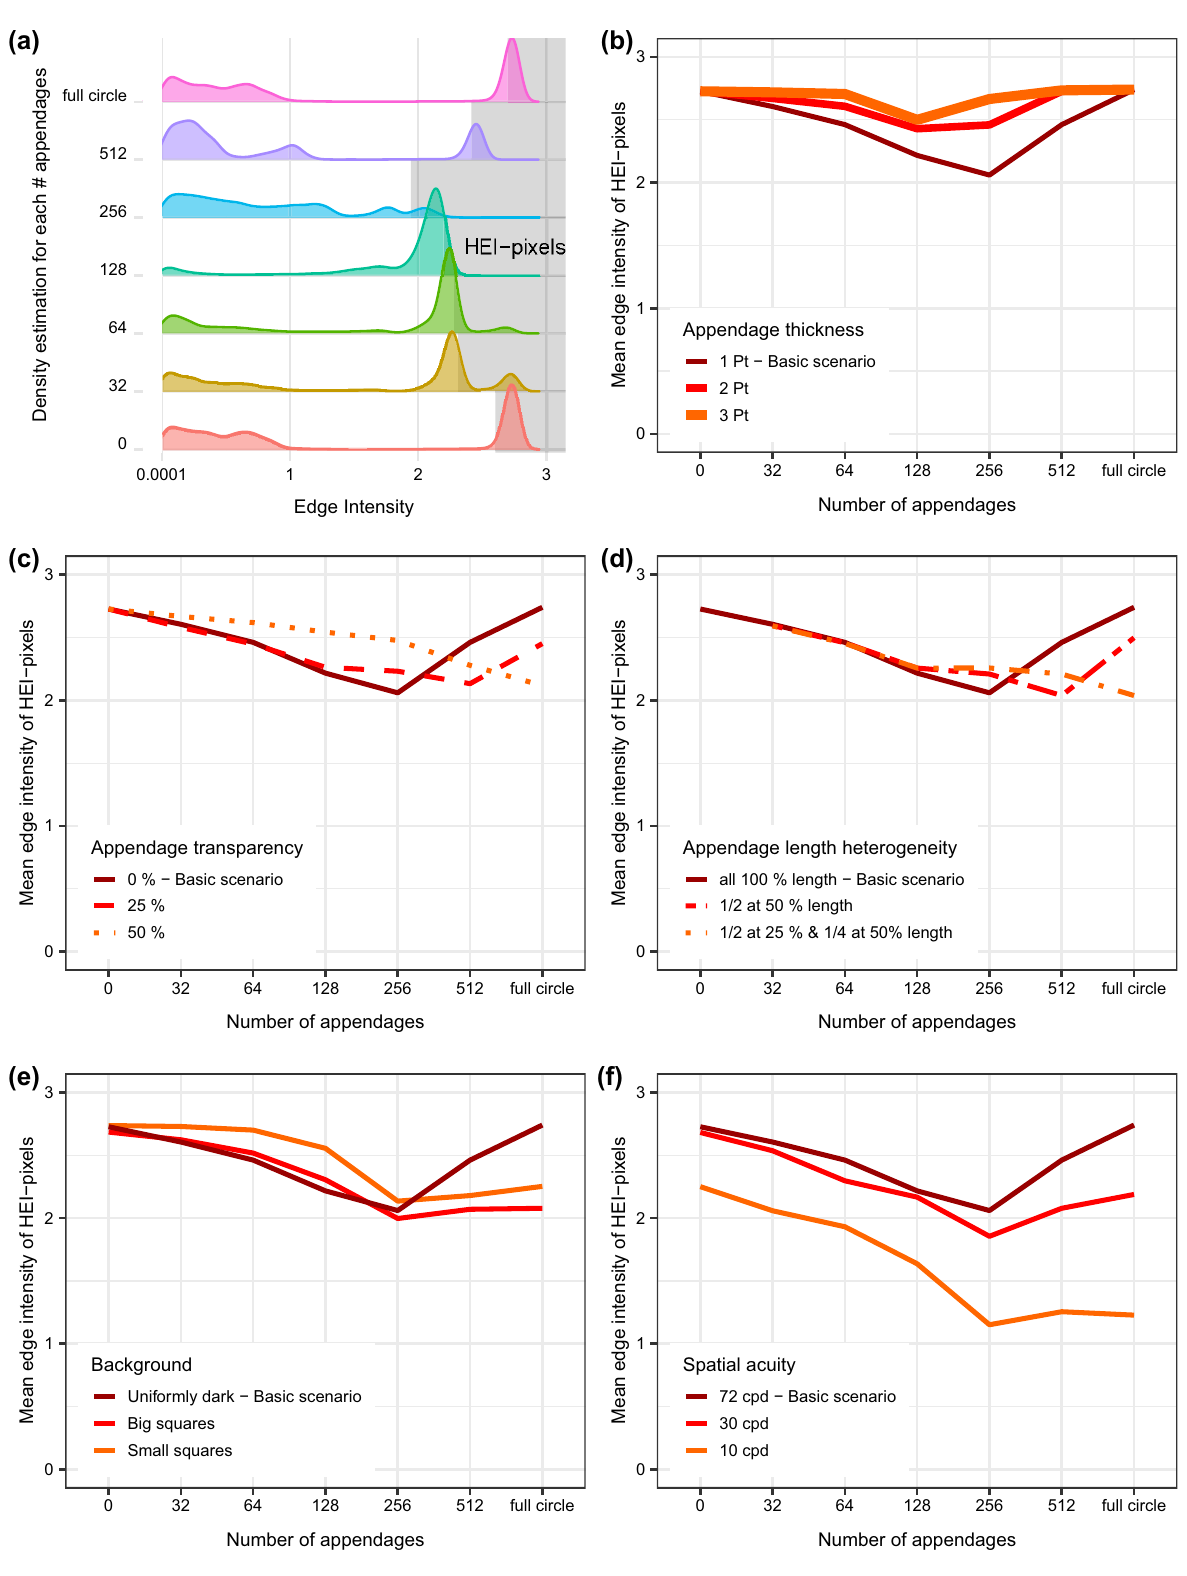
Figure 1. Local edge intensity analysis (LEIA) of the contour region in the artificial object experiment. (a) Ridgeline plots showing the density distribution of the edge intensity according to number of appendages. The highest 1.59% of the pixels are shaded in grey (high edge intensity pixels, HEI pixels). (b) Scenario 1: variation in appendage thickness. (c) Scenario 2: variation in appendage transparency. (d) Scenario 3: variation in appendage length. (e) Scenario 4: variation in background complexity. (f) Scenario 5: variation in spatial